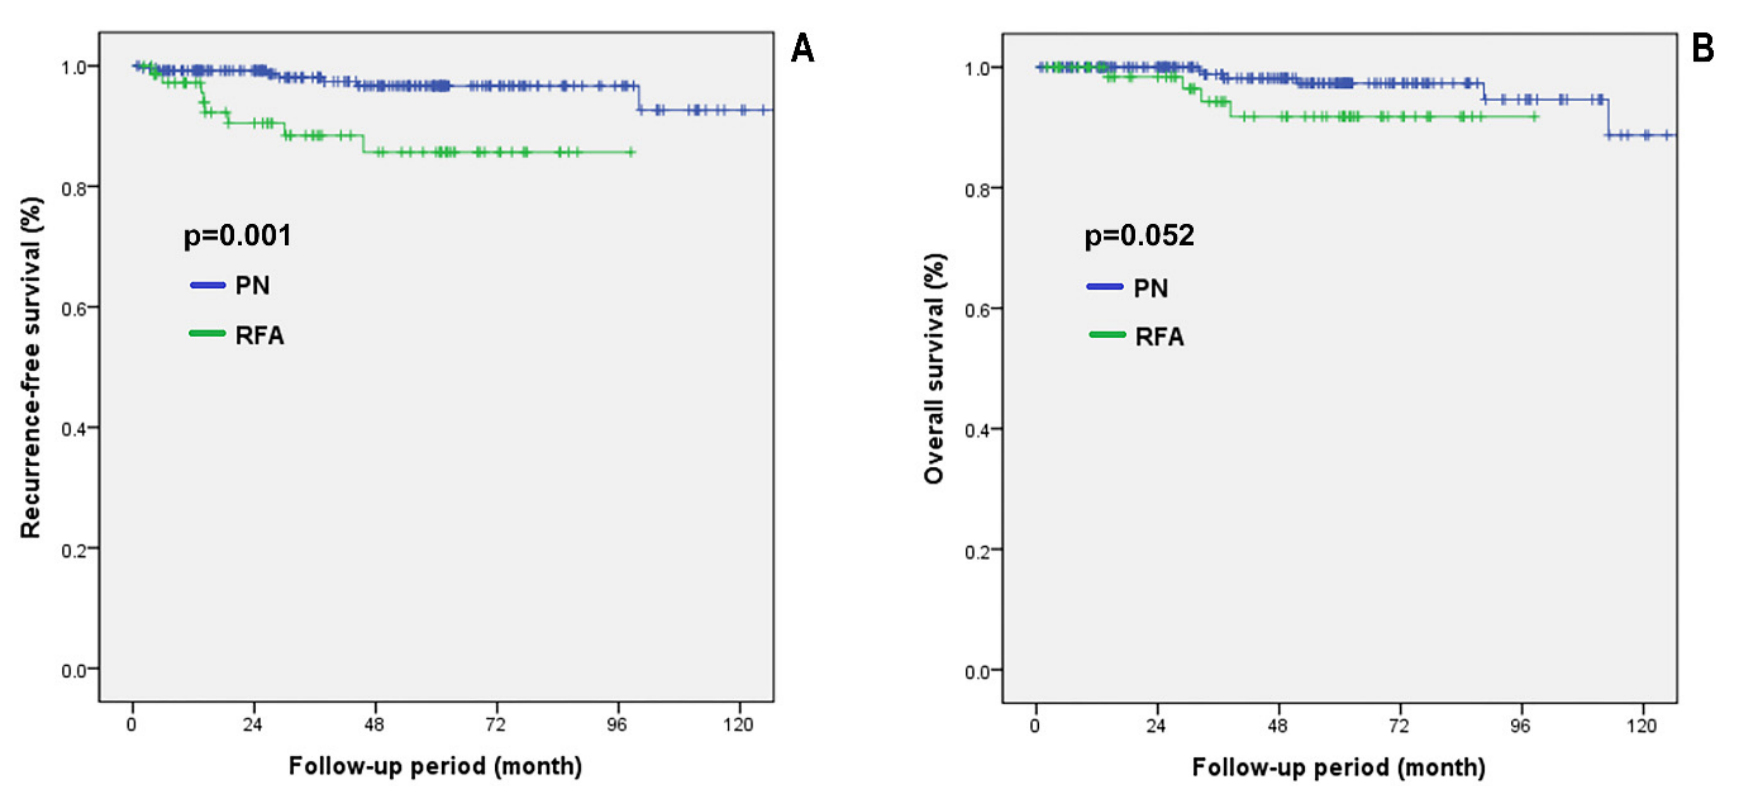
Figure 3. Survival analysis in propensity score matched cohorts with CKD stage 2. ( A ) RFS, recurrence-free survival; ( B ) OS, overall survival. PN: partial nephrectomy; RFA: radiofrequency ablation.